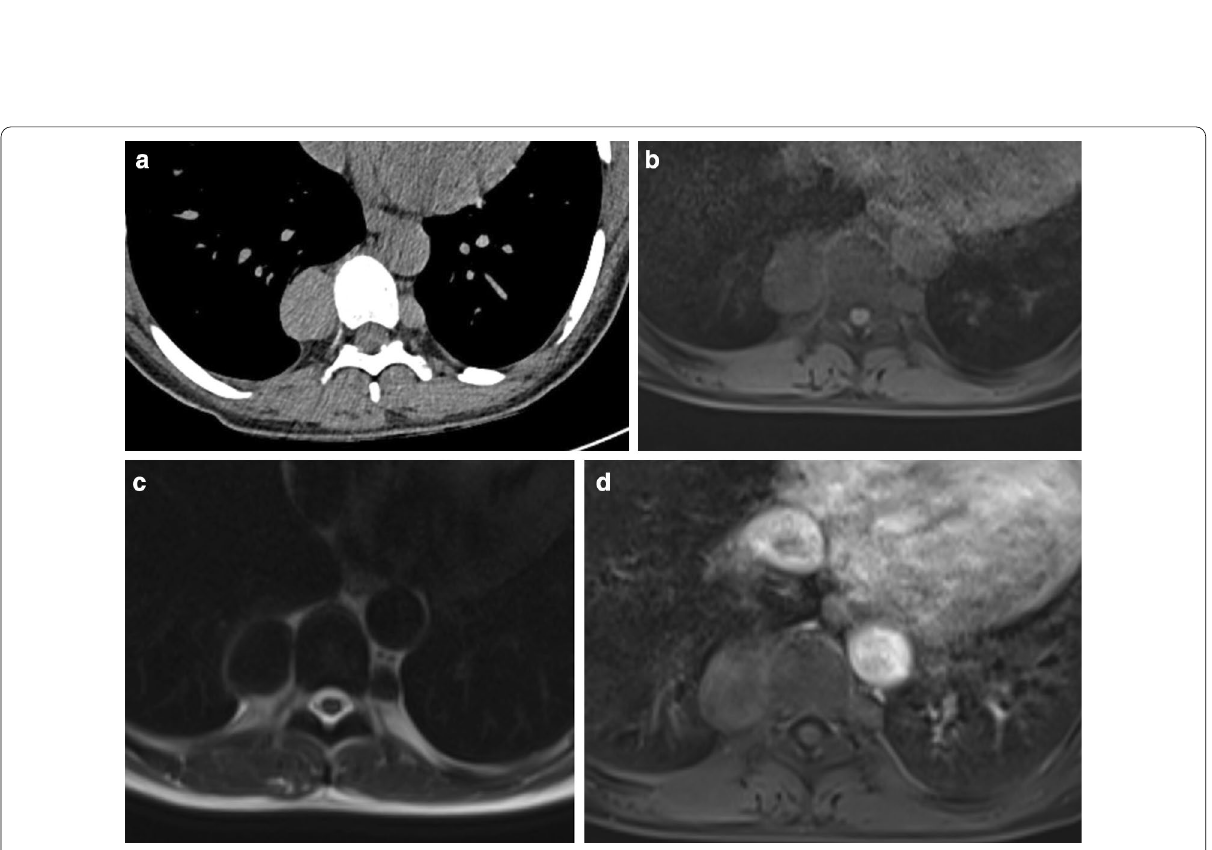
Fig. 20 Diagnosis: extramedullary hematopoiesis. Technique: chest CT and MRI. Description: A 42-year-old woman with sickle cell anemia was referred for a routine control examination. The axial CT in the mediastinal window setting ( a ) shows as incidental findings, two well-delineated paravertebral masses with a homogeneous hypodense aspect. There is no locoregional bone invasion. On both the axial T1 vibe MRI sequence with FS ( b ) and the axial T2 haste MRI sequence ( c ), the lesions have the same signal intensity as bone marrow. There is no contrast enhancement of the lesions on the axial T1 vibe sequence with FS ( d